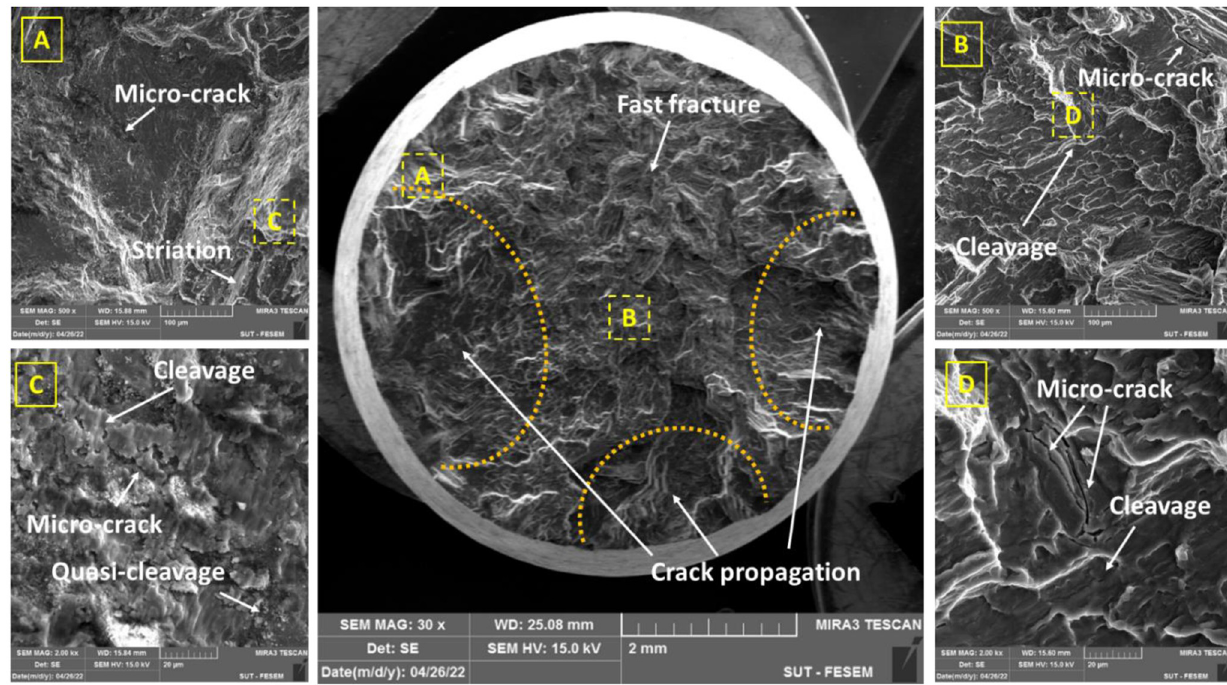
Fig 8. The fracture surface under pure fatigue conditions (the stress level: 120 MPa).